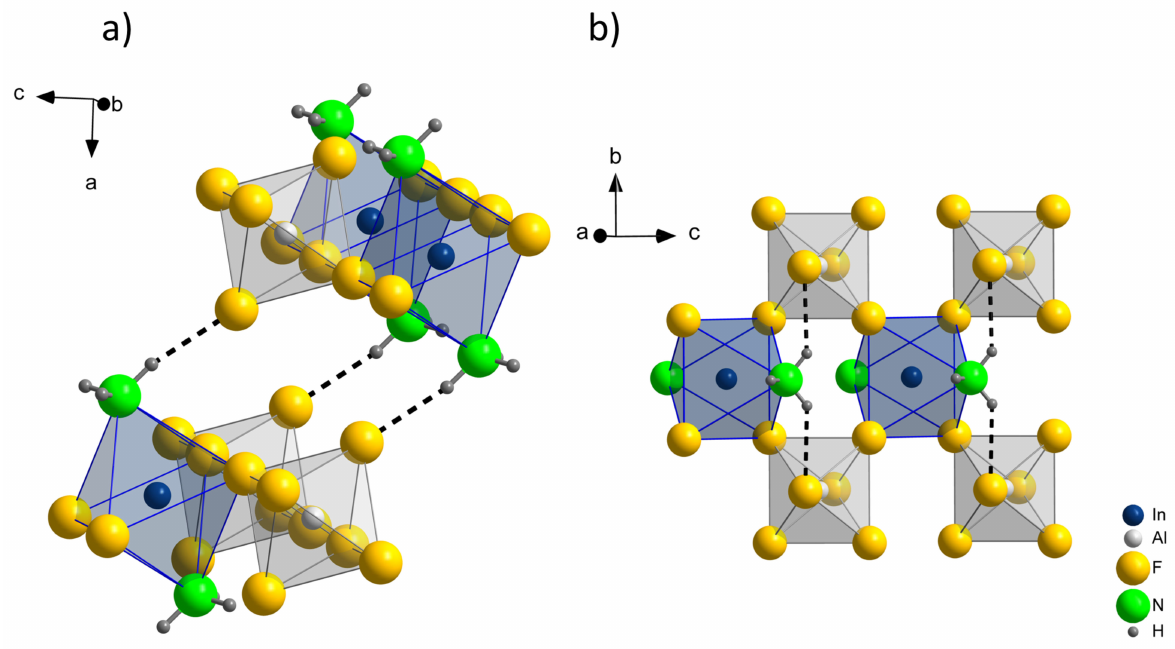
Figure 3. Arrangements of the different hydrogen bonds in InAlF 6 (NH 3 ) 2 , ( a ) N–H(2) · · · (2) interconnecting neighboring layers, ( b ) N–H(1) · · · F(2) located within the